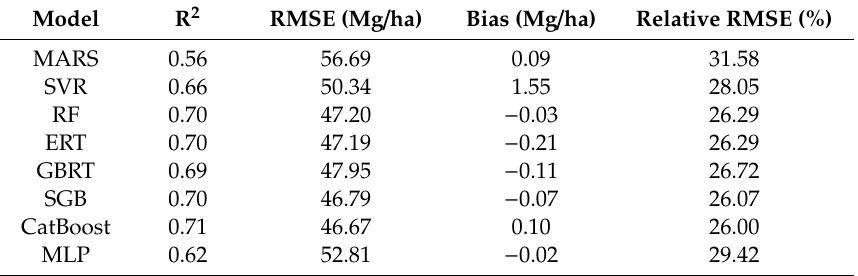
Table 3. Average performance metrics for the 50 runs of each regression algorithm under the random sampling